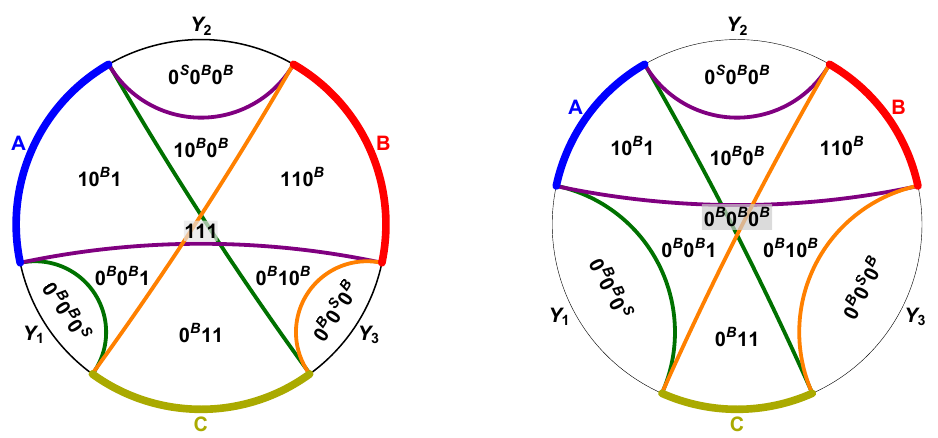
Figure 7 . Auxiliary geometries for inequality (5.1): geometry I (left) and geometry II (right). The boundaries of region W AB are marked in purple, the boundaries of W AC are marked in green, and the boundaries of W BC are marked in orange. We label the regions W ( ~x ) ~c with their ~x -vectors, e.g., 101 stands for W AB \ W BC \ W AC . Because each W I is in the disconnected phase, every 0-entry in l ~x carries a superscript that labels the color component of W I : B for the ‘bigger’ component and S l for the ‘smaller’ component (a single Y -interval). No color label is given for 1-entries in ~x because each W I is connected (and therefore has a single l